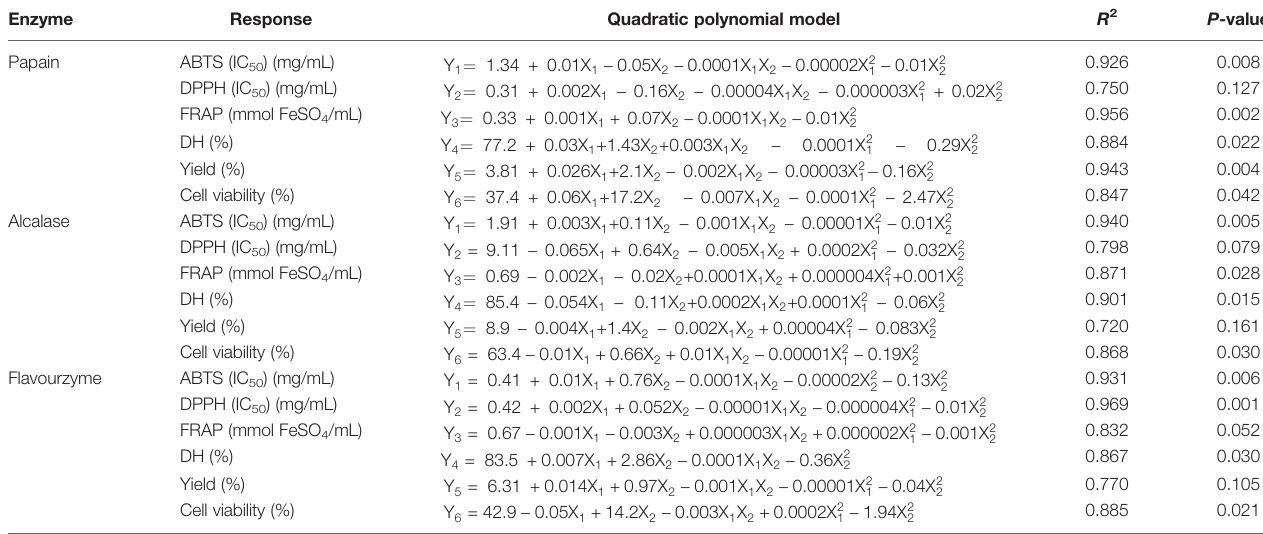
TABLE 3 | Response surface models for sea cucumber hydrolysates using papain (SCP), alcalase (SCA) and fl avourzyme (SCF). Enzyme Response Quadratic polynomial model